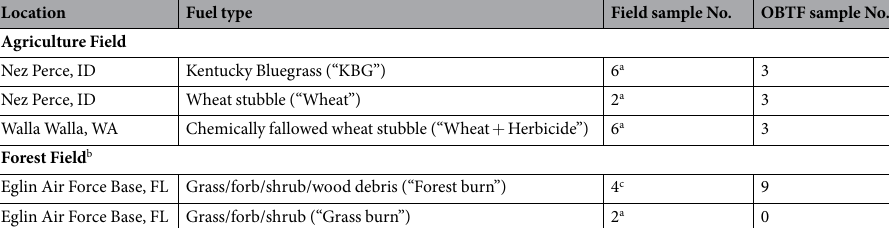
Table 1. Description of the location, fuel species and sample numbers for prescribed burns, and sample numbers for corresponding laboratory simulations at the open burn test facility (OBTF). a Contain equal numbers of ground and aerostat samples. b Aurell et al . 33 ; Holder et al . 39 c Contain 3 ground and 1 aerostat